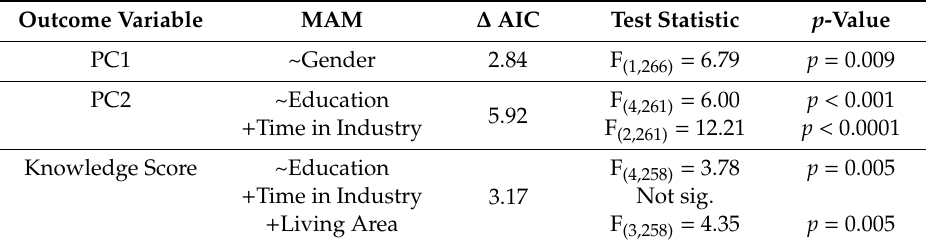
Figure 1. The effect of training delivery method (Direct or Remote) before (Pre-) and after (Post-) training on Knowledge Scores. Significant (* = p < 0.05) and non-significant (NS = p > 0.05) changes between before and after scores are indicated above the brackets. Table 3. Minimum Adequate Model (MAM) summaries of principal components one and two obtained from a PCA of attitudinal responses, and Knowledge score using backward stepwise selection. Change ( ∆ ) in AIC is the decrease in Akaike Information Criterion from the full model (~Gender + Age + Education + Time in industry, Type of living